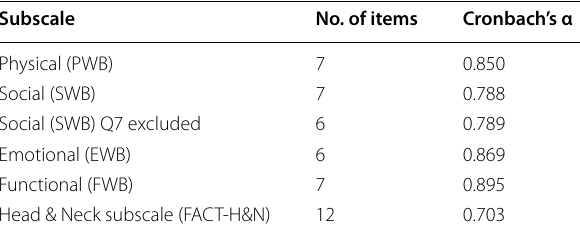
Table 2 Internal consistency results using cronbach’s alpha